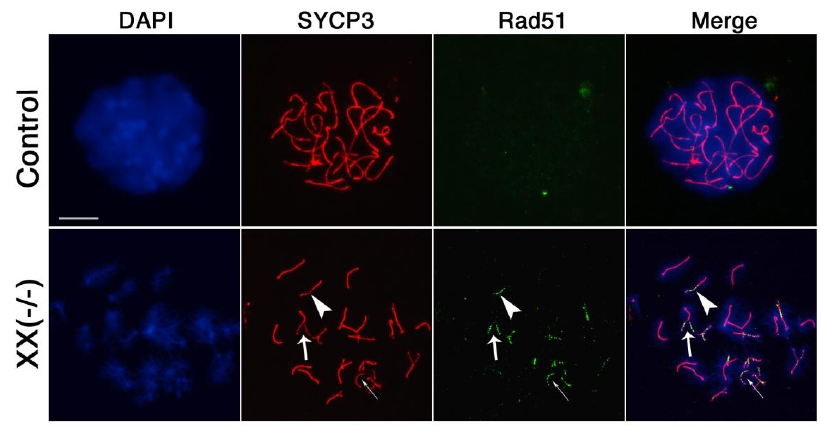
Figure 5. Rad51 foci associate with asynapsed chromosomes and chromosome segments in Cbx2 mutant oocytes. Complete meiotic chromosome synapsis in control oocytes is associated with the timely resolution of DSBs and lack of Rad51 foci at the pachytene stage (upper panel). In Cbx2 (XX−/−) mutant oocytes non-homologous and incomplete chromosome synapsis leads to persistence of Rad51 foci (green, arrow, thin arrow) on meiotic chromosome axes (lower panel). Moreover, Rad51 foci are also retained at chromosome cores that appear fully synapsed but exhibit axial gaps on the synaptonemal complex (arrowhead). SYCP3 is shown in red and DNA is shown in blue. Scale bar = 10 